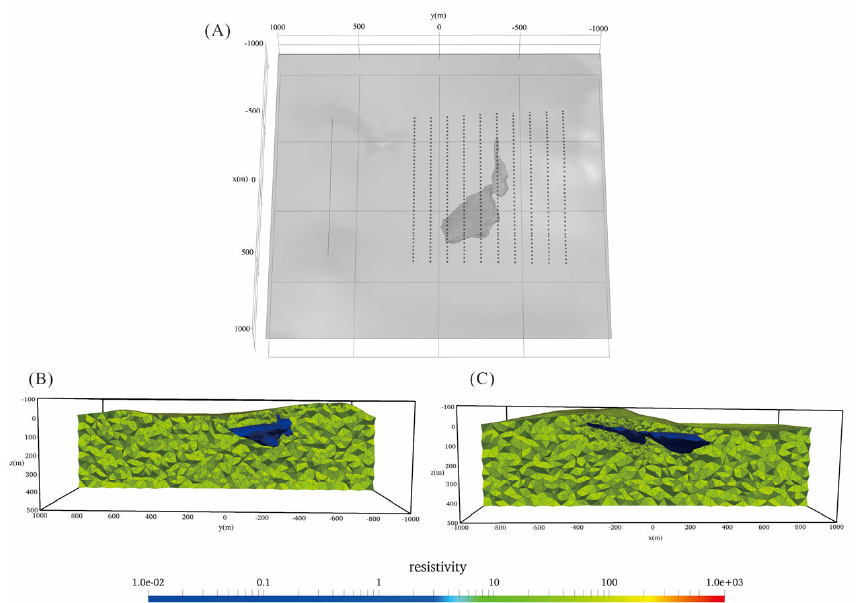
Figure 10. The Ovoid massive sulfide ore body model. ( A ) shows the locations of source and survey points with the ore body ( B ) and ( C ) show the model discretization from two clips at x= − 200 m and y=0 m, respectively . Note that the background resistivity is also clipped to show the whole ore model.